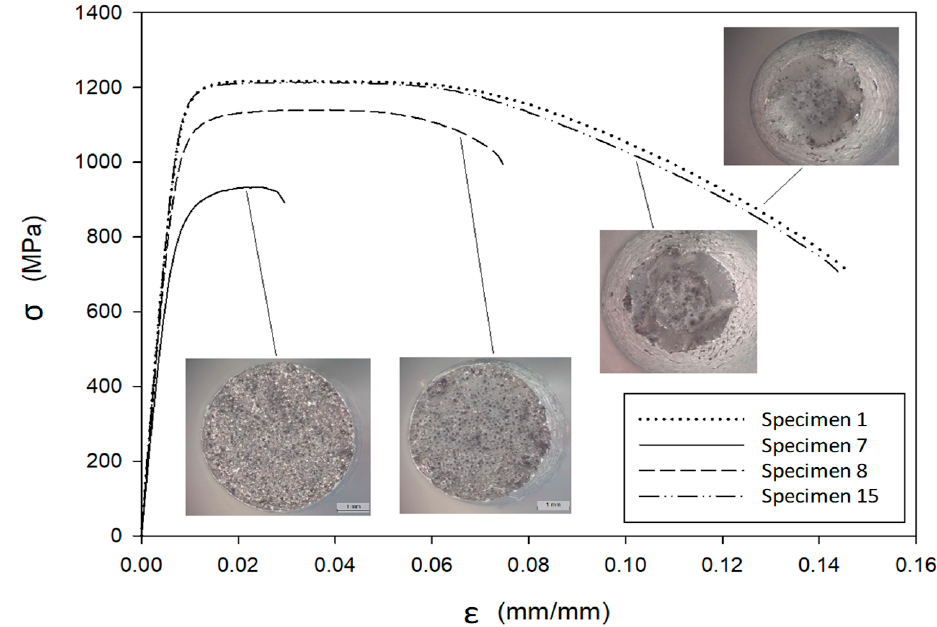
Figure 2. Stress–strain curves of the tested specimens.